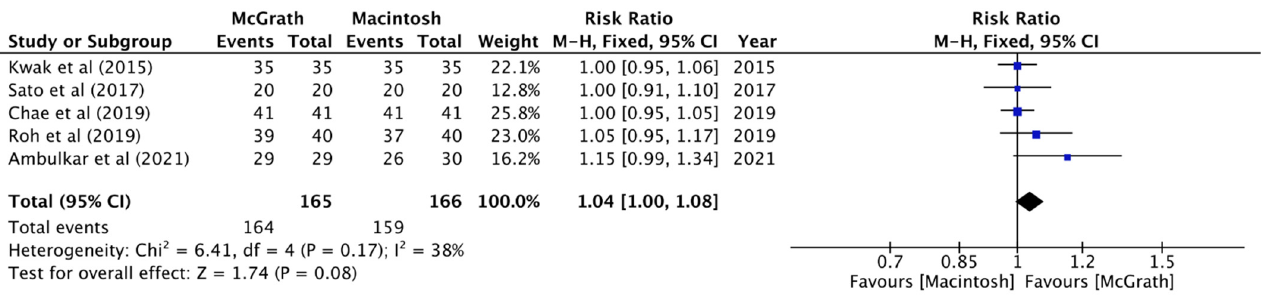
Figure 5. Forest plot of the Magill forceps used (McGrath vs. Macintosh laryngoscope).